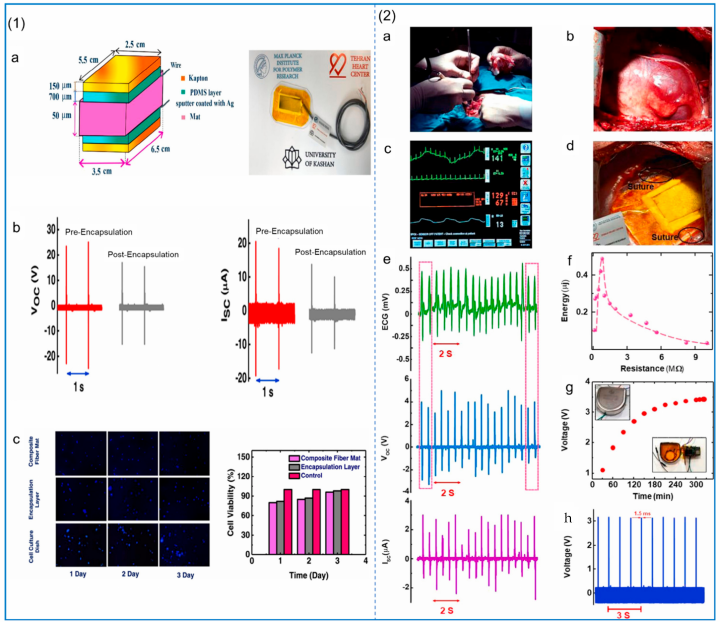
Figure 9. ( 1 ) PNG structure diagram and its voltage, current, and biocompatibility test, ( a ) Schematic diagram and photo of PNG. ( b ) Open − circuit voltage and short − circuit current before and after PNG packaging. ( c ) Fluorescence images and viability of MEF cells after 1, 2, and 3 days of culture on composite fibrous membranes, encapsulated layers of PNG, and cell culture dishes. Reprinted with permission from Ref. [129], copyright 2021, Elsevier. ( 2 ) Self − powered cardiac pacemakers and ( a ) surgical procedures in animal experiments. ( b ) Photographs of the heart and ( c ) ECG signals and blood pressure recorded simultaneously. ( d ) PNG stitched to the epicardium facing the left outdoor lateral wall ( e ) In vivo ECG signal, open − circuit voltage, and short-circuit current of PNG. ( f ) Energy generated by PNG. ( g ) Charging curve of a 100 µ F capacitor charged by PNG. ( h ) Pacing pulses generated by a PNG − powered pacemaker. Reprinted with permission from Ref. [129], copyright 2021,